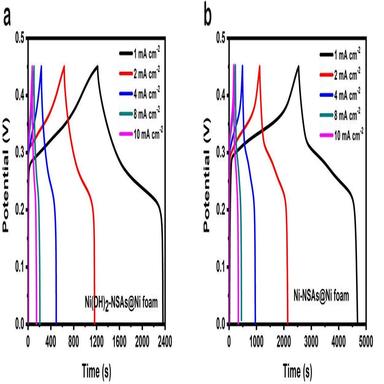
Shows galvanostatic charge/discharge (GCD) curves of (a) Ni(OH)2-NSAs@Ni foam and (b) Ni-NSAs@Ni foam at different current densities with potential range of (0–0.45) V.